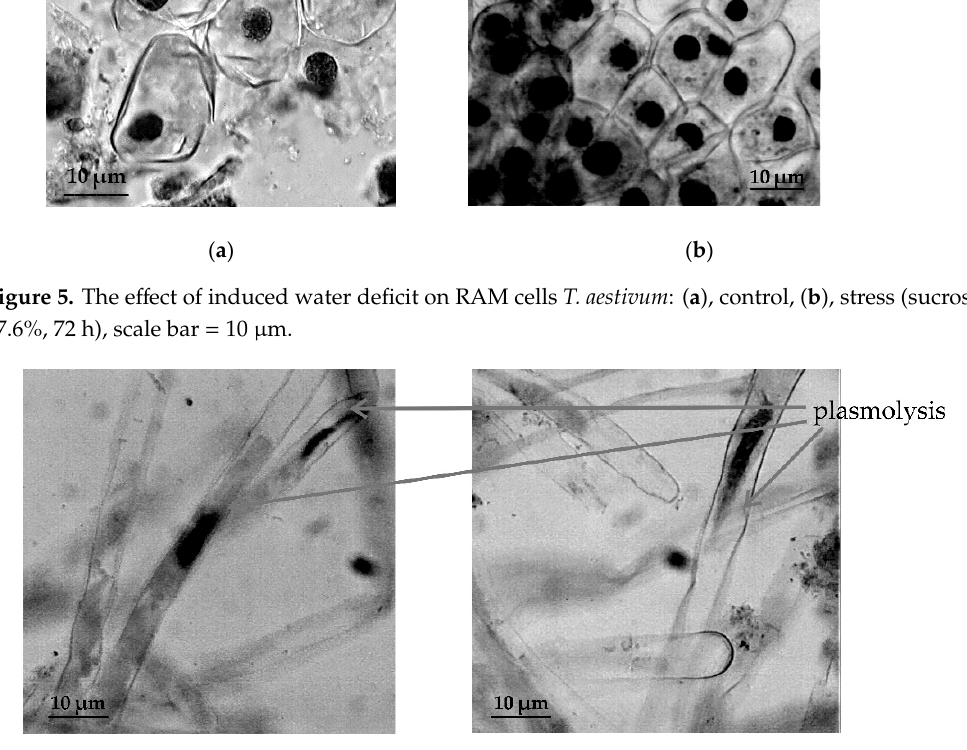
Figure 6. The effect of induced water deficit on root hairs cells T. aestivum (sucrose, 17.6%, 72 h), scale